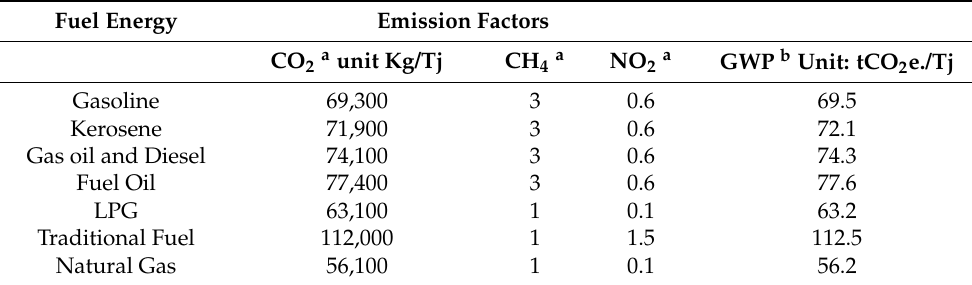
Table 2. GHG emission factors in various fuels.